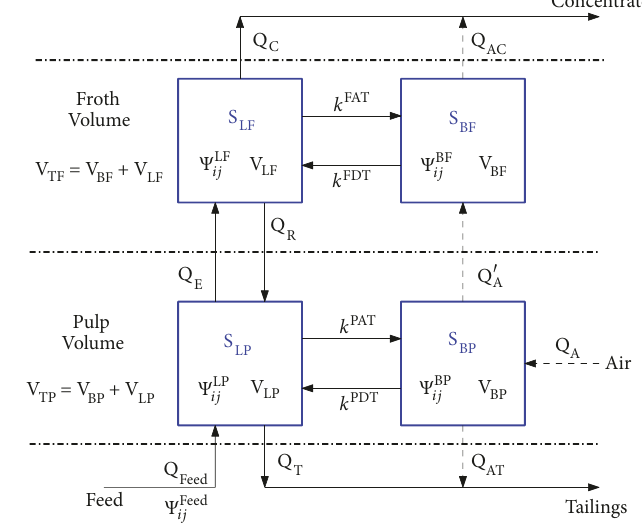
Figure 3: Particle movement in a flotation